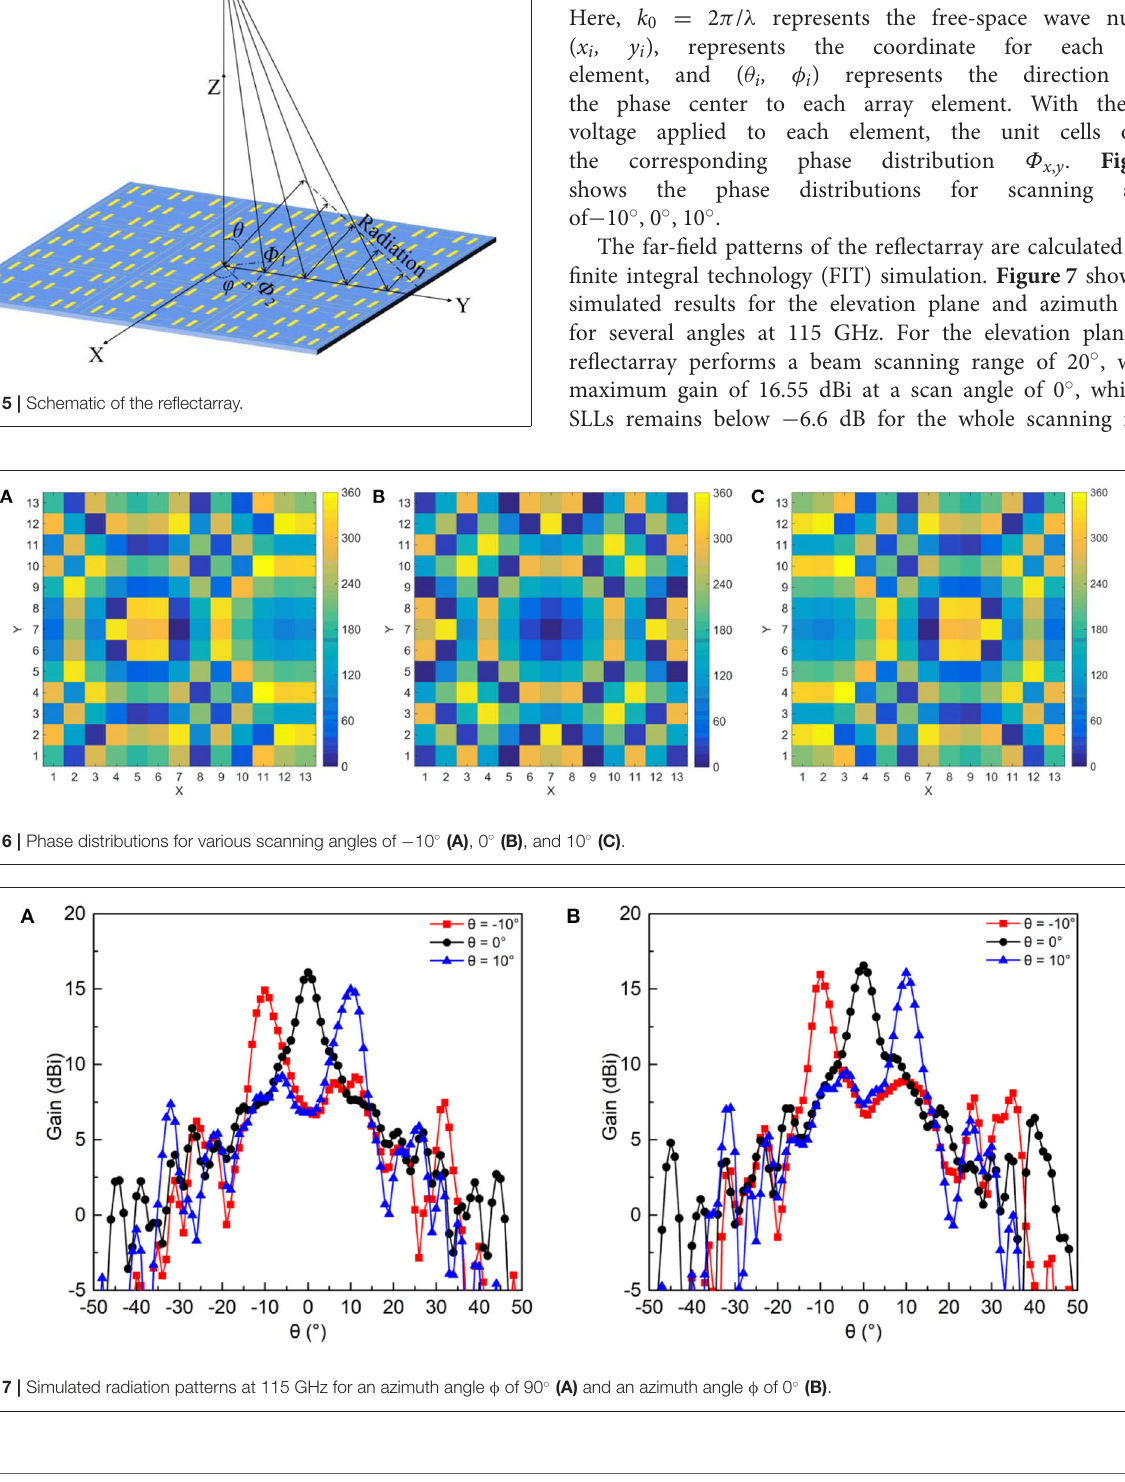
Frontiers in Physics |